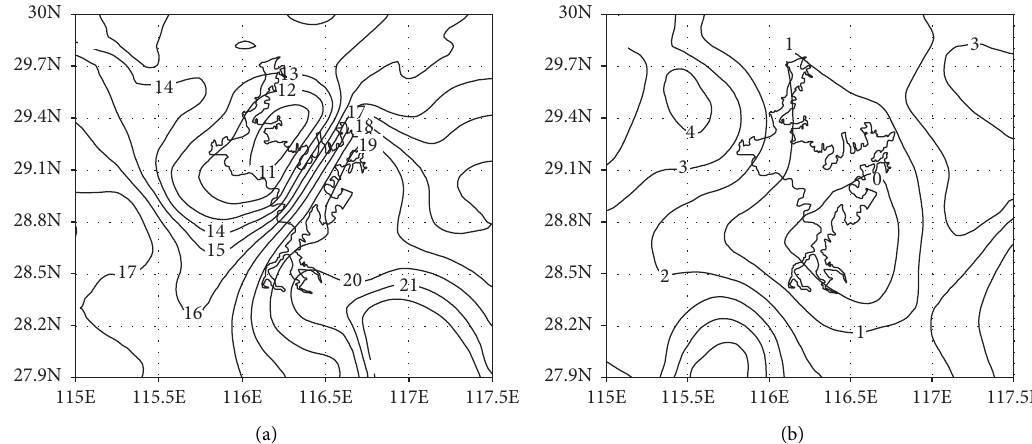
Figure 6: The time distribution of the first maximum of harmonics with (a) diurnal (24hours) cycle and (b) semidiurnal (12 hours) cycle. –1–0.500.51